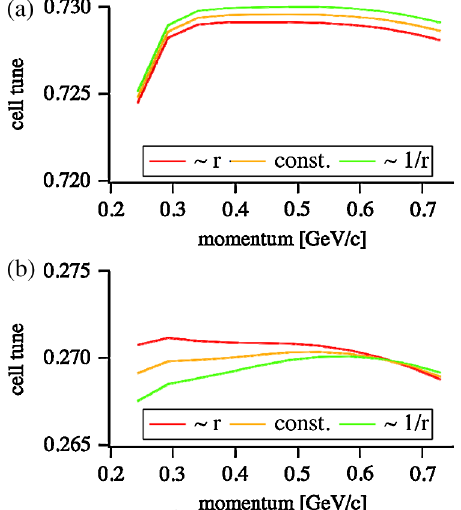
FIG. 4. (Color) Cell tunes throughout acceleration for the case of wedge-shaped magnets with different models of the fringe field falloff. Horizontal cell tune in (a) and vertical cell tune in (b). Notice that the scale of ordinate is 10 times smaller than Fig.